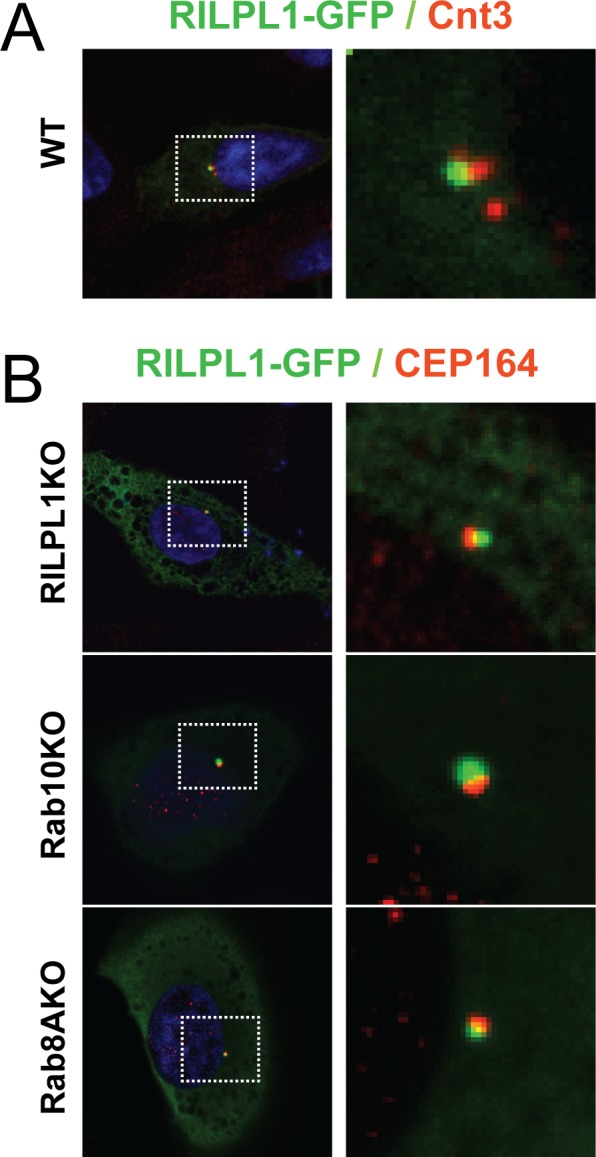
RILPL1 localizes to mother centrioles.Wild type, Rab8A-KO, Rab10-KO and RILPL1-KO A549 cells were transfected with RILPL1-GFP. After 24 hr, cells were fixed and stained with antibodies against the general centriolar marker, mouse anti-Centrin-3 or with a mother centriole-specific marker, mouse anti-CEP164 antibodies and co-stained with chicken anti-GFP. (A) RILPL-GFP (green) and Centrin-3 (red). (B) RILPL1-GFP (green) and CEP164 (red). Knock out cell lines are indicated. Dotted box indicates the areas magnified in the insets.